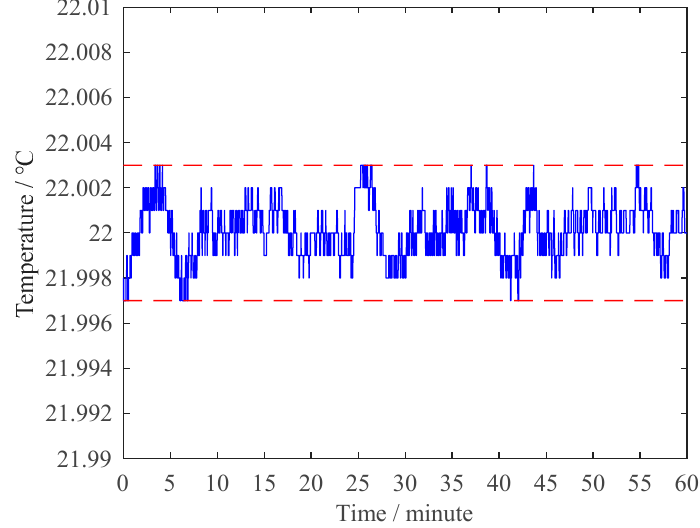
Figure 11. Experimental results of CCW temperature stability.